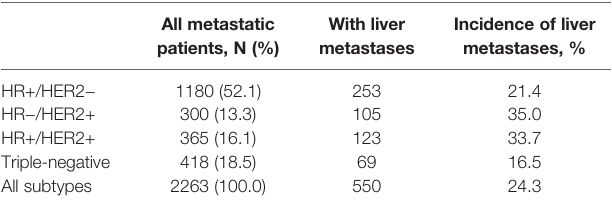
HR, hormone receptor; HER2, human epidermal growth factor receptor incidence proportions of liver metastases, while triple-negative (16.5%) the lowest. Table 3 . Patients with de novo stage IV breast cancer were more likely to present with liver metastases than recurrent MBC patients (M1 vs. M0, OR = 1.44, 95% CI = 1.08 – 1.93, P = 0.013). HR − /HER2+ ( vs. HR+/HER2 − , OR = 1.92, 95% CI = 1.44 – 2.55, P = 0.000) and HR+/HER2+ ( vs. HR+/HER2 − , OR = 1.80, 95% CI = 1.38 – 2.34, P = 0.000) subtypes were associated with remarkably higher odds of liver metastases, while triple-negative subtype ( vs. HR+/HER2 − , OR = 0.71, 95% CI = 0.53 – 0.96, P = 0.024) was associated with signi fi cantly